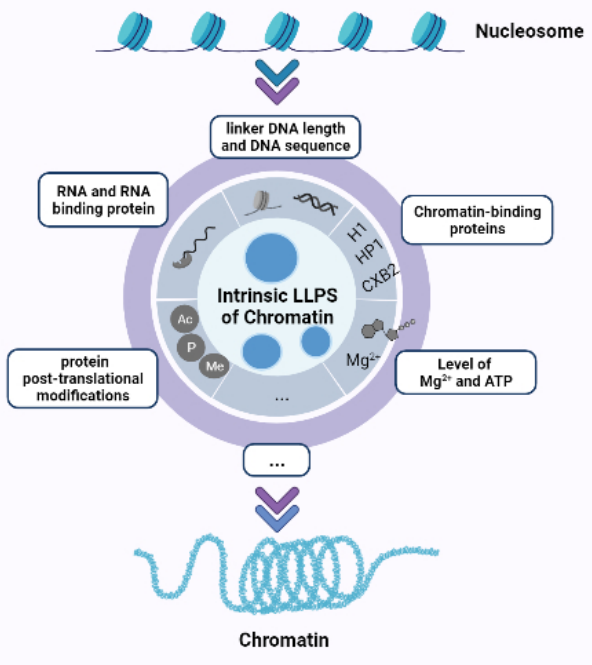
Figure 1. Regulation of chromatin organization by phase separation. Linker DNA length and DNA sequence specificity, chromatin-binding proteins (i.e., H1, HP1, and CXB2), level of Mg2+ and ATP, RNA and RNA binding protein, and protein post-translation modifications (i.e., phosphorylation, acetylation, and methylation) can all affect chromosome organization by different phase separation. There are still more factors affecting chromosome organization by phase separation to be explored in further studies.